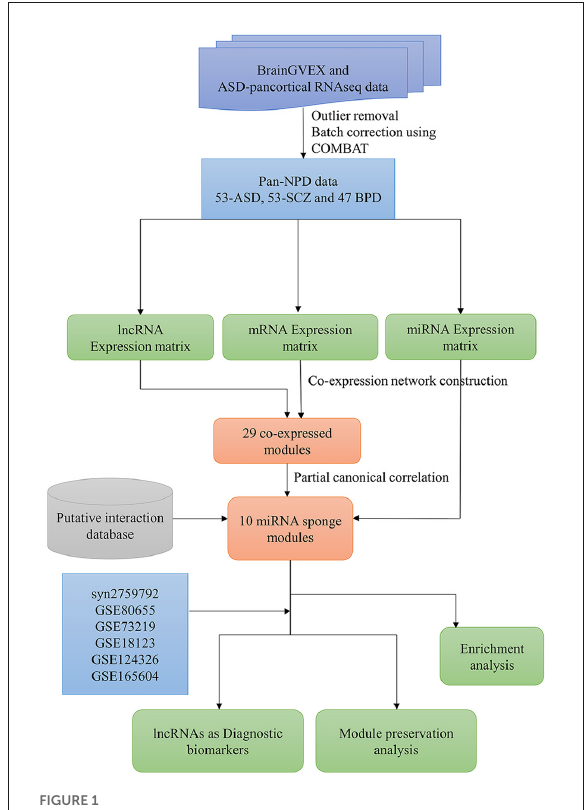
FIGURE1 The workflow to infer the lncRNA-related miRNA sponge modules in pan-neuropsychiatric orders.